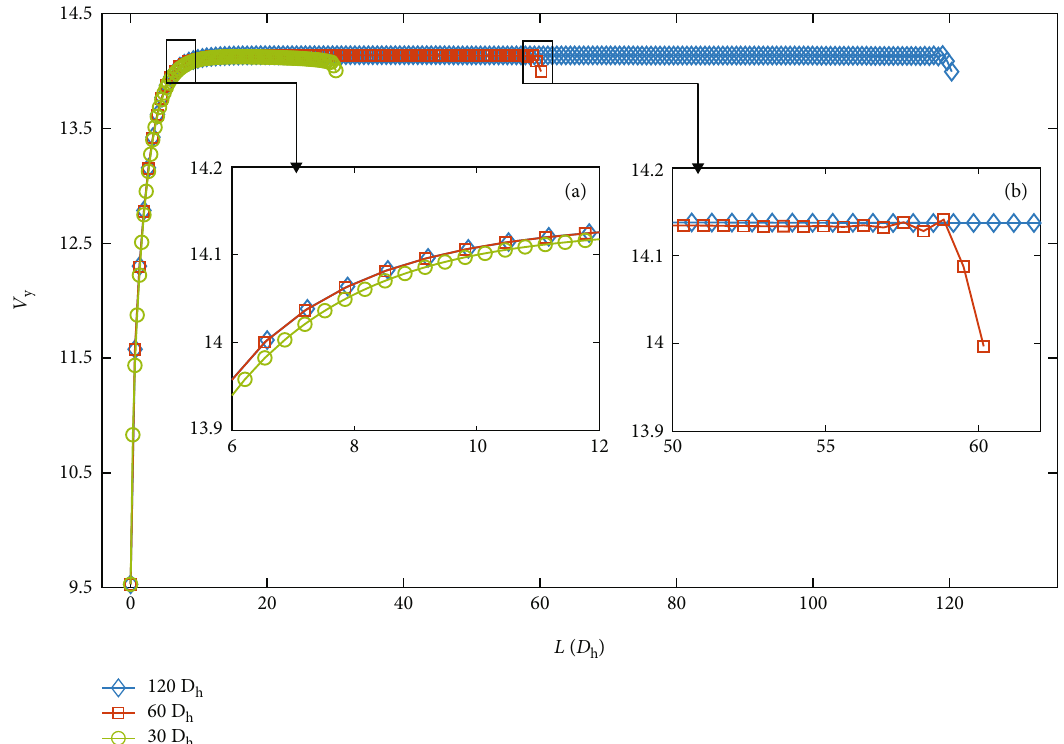
, 60 D , 120 D . h h h